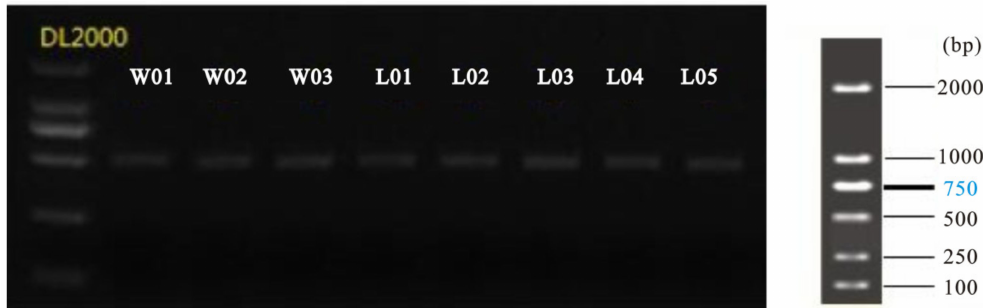
Figure 2. The results of PCR amplification were identified by 2% agarose